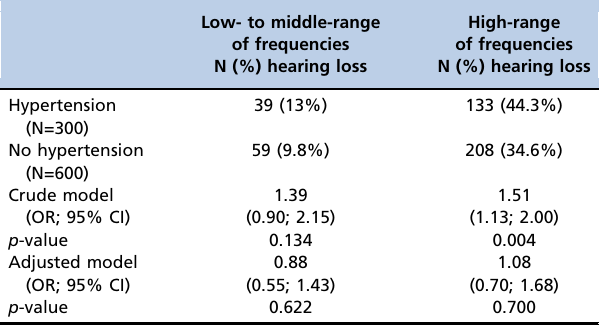
Figure 1 - Means of hearing thresholds in the subgroup with time from the diagnosis of hypertension o 6 years (N=141) and in the subgroup with time from the diagnosis of hypertension X 6 years (N=153). RE, right ear; LE, left ear; H, hypertension. Table 4 - Number of individuals with hearing loss in each range of frequencies (low to middle or high) with and without hypertension, ORs, and p -values in the crude and adjusted